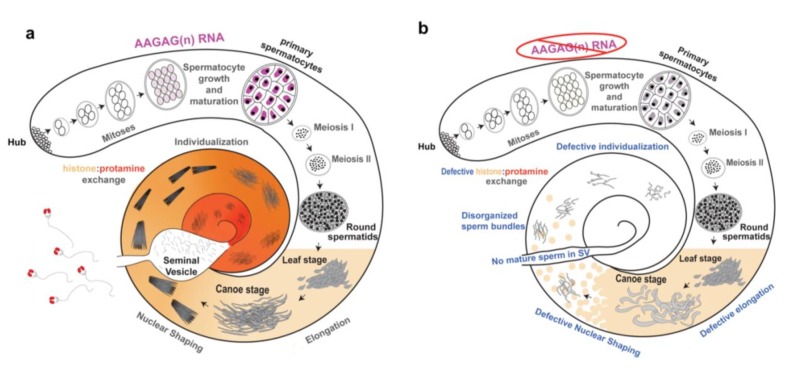
Overview of normal spermatogenesis and defects observed after AAGAG RNA depletion.(a) Spermatogenesis in Drosophila melanogaster initiates at the apical end of the testes (Hub), where GSCs divide asymmetrically, producing gonialblasts (GBs) that begin cell-differentiation. GB cells then undergo four mitotic divisions with incomplete cytokinesis to produce a cyst of 16 primary spermatocytes. Spermatocytes then undergo pre-meiotic S phase, mature during a prolonged G2 phase, and increase substantially in volume. The majority of testes-specific gene expression occurs at the primary spermatocyte stage, while genes not required until later stages are translationally repressed (reviewed in White-Cooper, 2010). Mature spermatocytes then undergo two rounds of meiosis to produce round spermatids (McKee et al., 2012), which are then processed into independent, condensed sperm nuclei in two stages (Rathke et al., 2014; Eren-Ghiani et al., 2015; Steinhauer, 2015). First, round spermatids undergo chromatin compaction, acrosome formation and flagellar elongation (Rathke et al., 2014; Eren-Ghiani et al., 2015). During chromatin compaction, a wave of histone H4 acetylation occurs, followed by deposition of the transition protein Mst77f, (Kost et al., 2015). Next, transition proteins are removed followed by the incorporation of protamines and prtl99c (histone:protamine exchange, indicated by tan to deep orange gradient) (Rathke et al., 2014; Eren-Ghiani et al., 2015). Finally, spermatid individualization involves removal of cytoplasm and tight condensing and coiling of chromatin (Steinhauer, 2015). Mature sperm are then stored in the seminal vesicle. (b) Summary of defects in late stages of spermatogenesis observed after depletion of AAGAG RNA by RNAi, using the Bam-Gal4 driver (data in Figure 3). Although AAGAG RNA is not visible in normal testes after the S6 spermatocyte stage (see a), RNAi depletion of AAGAG RNA only produces visible defects after the round spermatid stage. Aberrant elongation, sperm bundles, and defective histone:protamine exchange likely cause the observed complete absence of mature sperm in the SV.